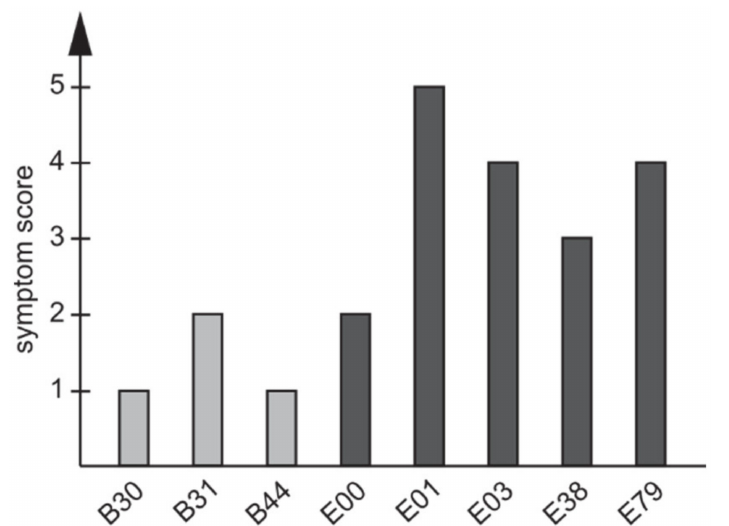
Figure 2. Symptom scores in individuals infected with C. jejuni ST353CC isolates. Three individuals (B30, B31, and B44) were infected with ST-9438 isolates and had traveled to Bangladesh. The rest of the individuals had traveled to Ecuador. Symptoms score 1–5: 1 indicates no symptoms, and 5 indicated the most severe